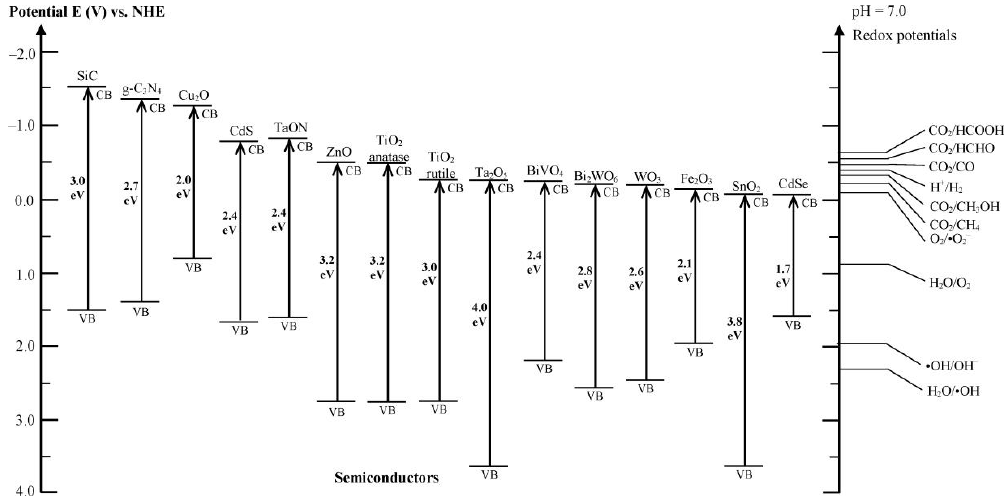
Figure 2. Band edge positions of various semiconductors with respect to the water redox potentials. Reprinted with permission from [3]. Copyright 2016, American Chemical Society.